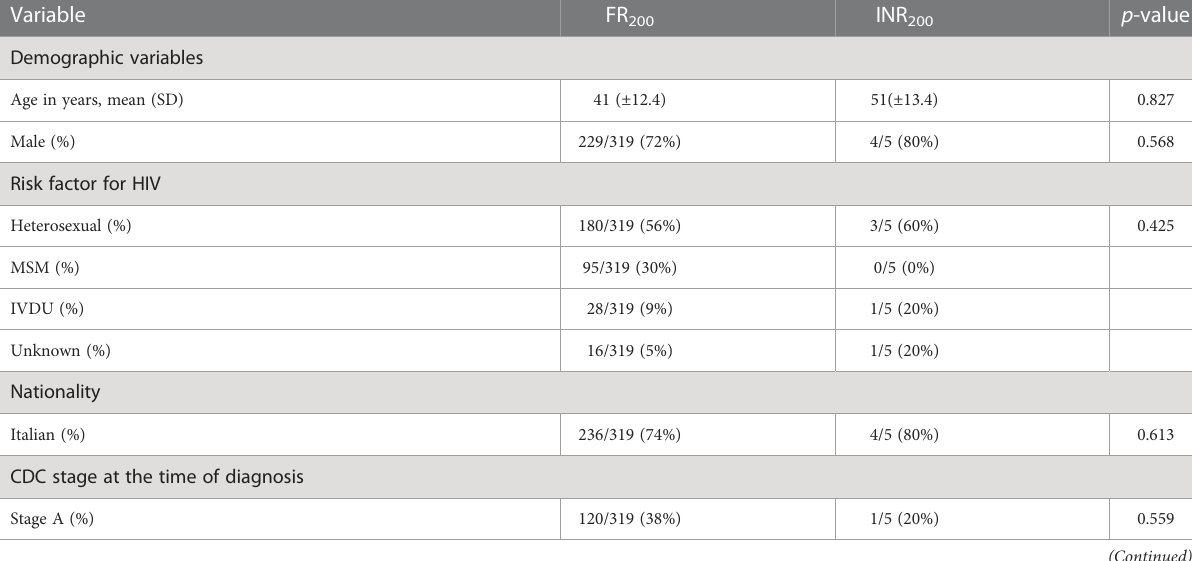
TABLE 4 Comparison of clinical and demographic characteristics of INR 200 and full